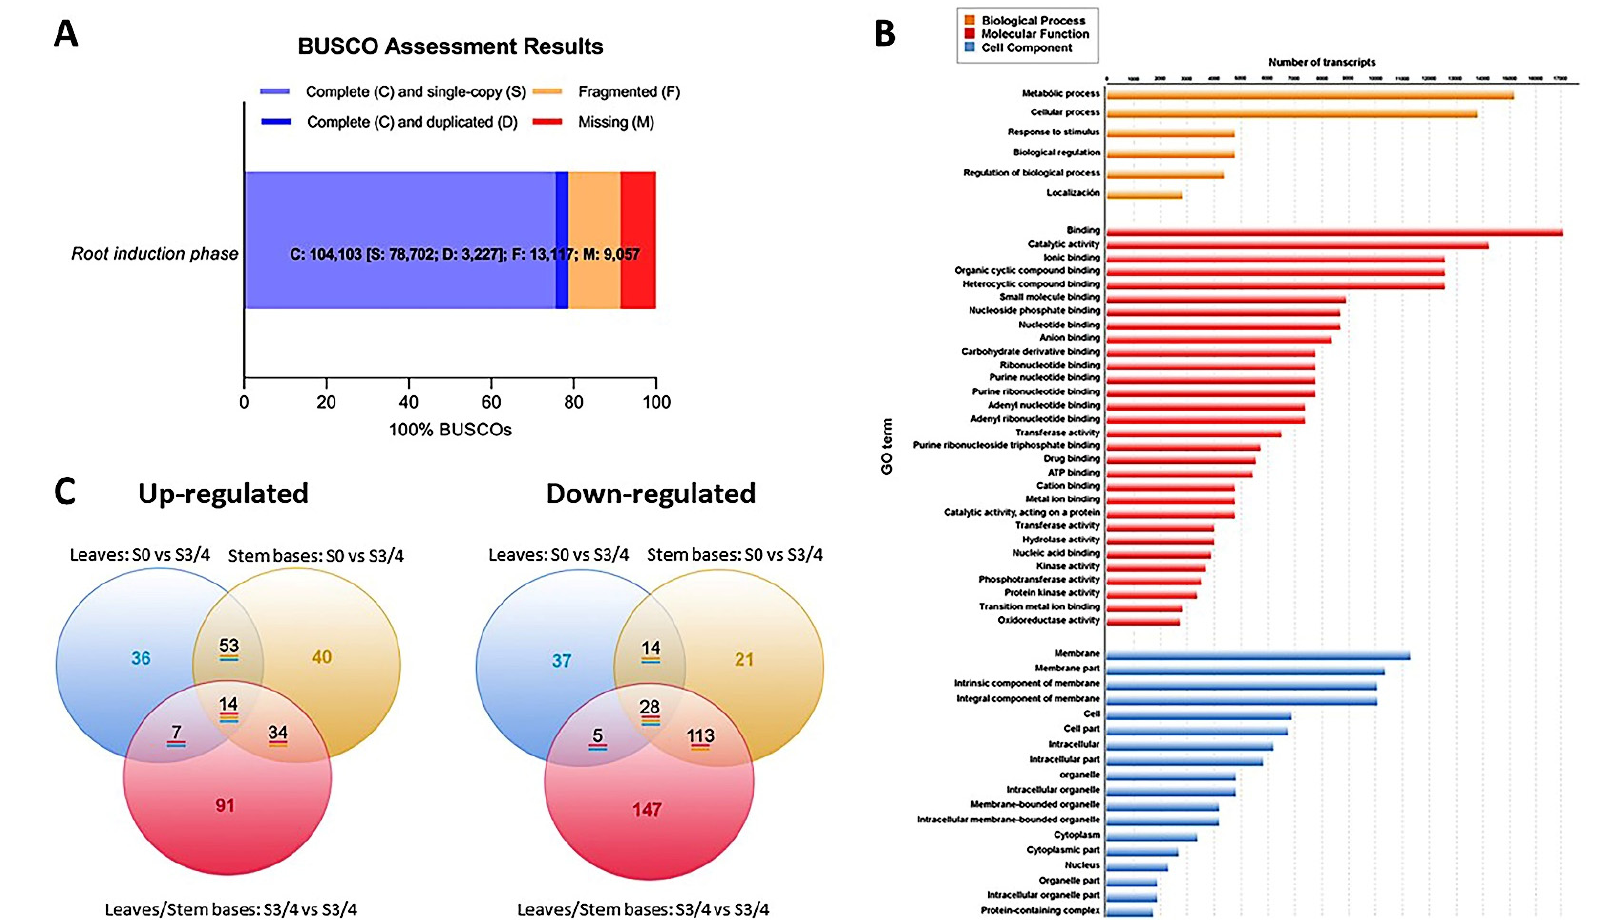
Figure 4. Data integrity assessment and annotation analysis. ( A ) BUSCO completeness assessment of the whole transcriptome data. The numbers indicate the absolute amount of complete and single ‐ copy, complete and duplicated, fragmented, and missing BUSCO genes. ( B ) GO terms from leaves and stem bases transcripts. ( C ) Venn diagrams of differentially expressed genes in leaves and stem bases during root induction. The number of transcripts common in two or more comparative samples is enclosed in the overlapping portion of the circles.